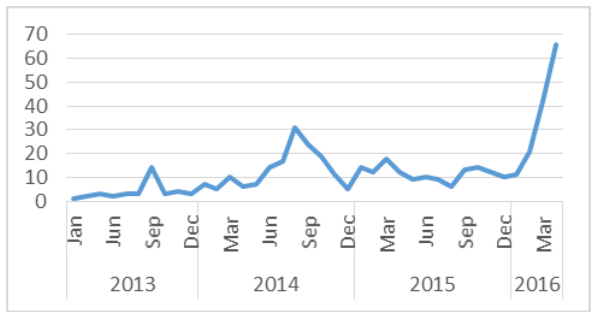
Figure 8. Data Requests per